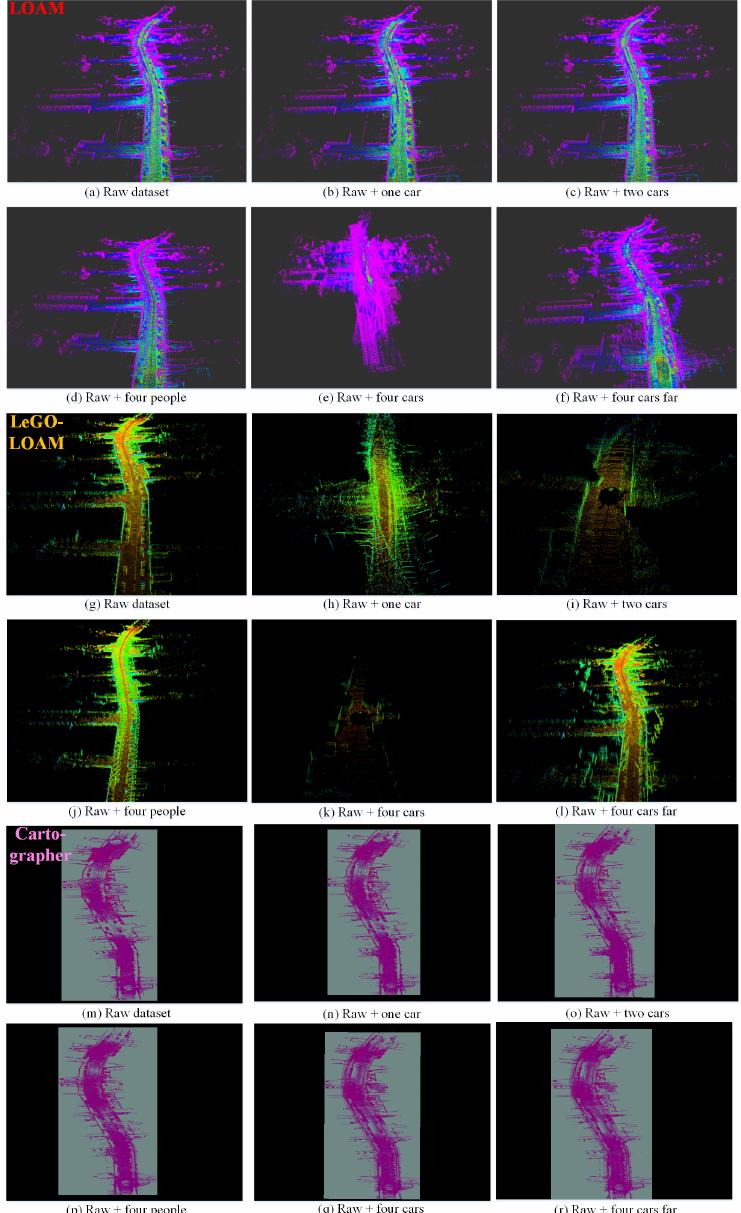
Figure 11. The mapping results (3D view) of LOAM ( a – f ), LeGO-LOAM ( g – l ) and Cartographer ( m – r ) in different simulated scenarios based on KITTI_0095_sim. ( a , g , m ) are the results on the original static data, used as baseline. More dynamic objects result in worse mapping results, and even total failure in some scenarios such as ( e , h , i , k ). LeGO-LOAM is more sensitive to moving objects in this